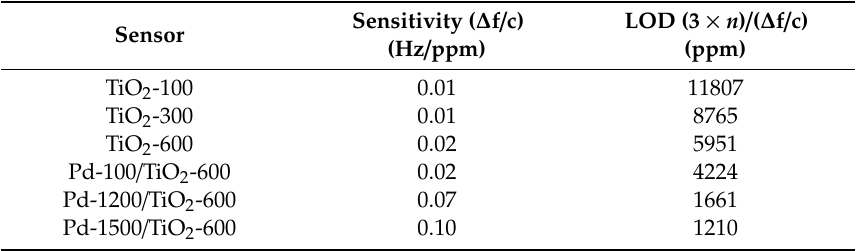
Table 2. Sensitivity and limit of detection (LOD) of the sensors. Legend: ∆ f-frequency change; c-hydrogen concentration, n -noise